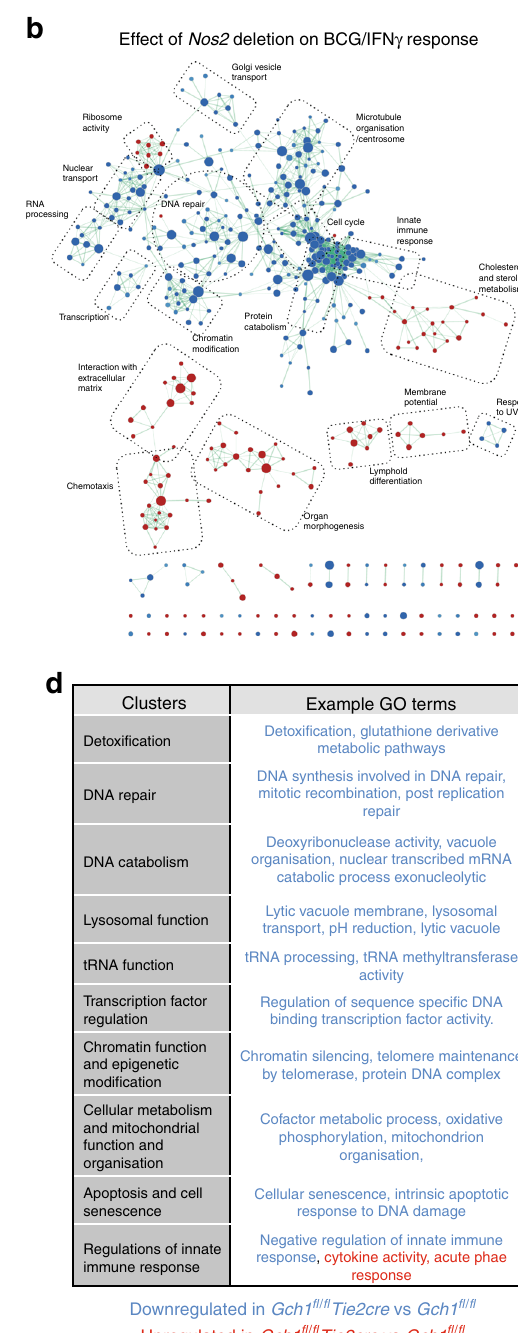
Fig. 6 GSEA identi fi es unique gene expression patterns in Gch1 cells. Gene expression data from both Gch1 and Nos2 de fi cient macrophages were analysed for GO term (biological processes) enrichment by Preranked gene-set enrichment analysis (GSEA) vs their wildtype control. The result was visualized as a network of gene sets (nodes) connected by their similarity (edges), compiled in Cytoscape using the Enrichment Map plug in. Node size represents the gene-set size and edge thickness represents the degree of overlap between neighboring gene sets. The GSEA output fi les were given analysed with a statistical cutoff set at p < 0.005 and FDR q < 0.1. The individual Enrichment Maps were plotted in Cytoscape for infected a Gch1 and b Nos2 macrophages and clusters were annotated by hand. To determine if regulated genesets were shared between the Gch1 and Nos2 knockout macrophages the signi fi cantly regulated gene sets were compared and a subset of genesets unique to Gch1 de fi cient macrophages was created, this subset ( c ) was plotted using Enrichment Map and the clusters annotated. d A table summarizing the GO-term clusters, with exemplar GO